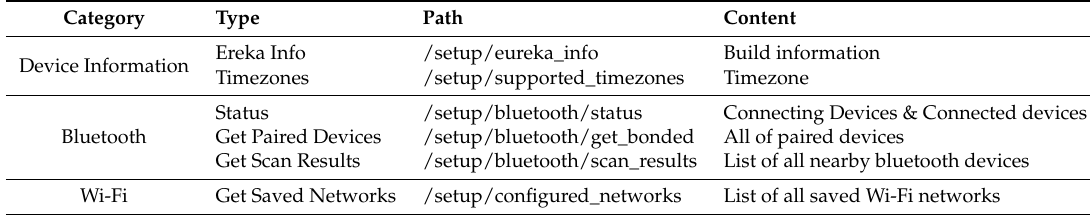
Table 6. List of private Google Home